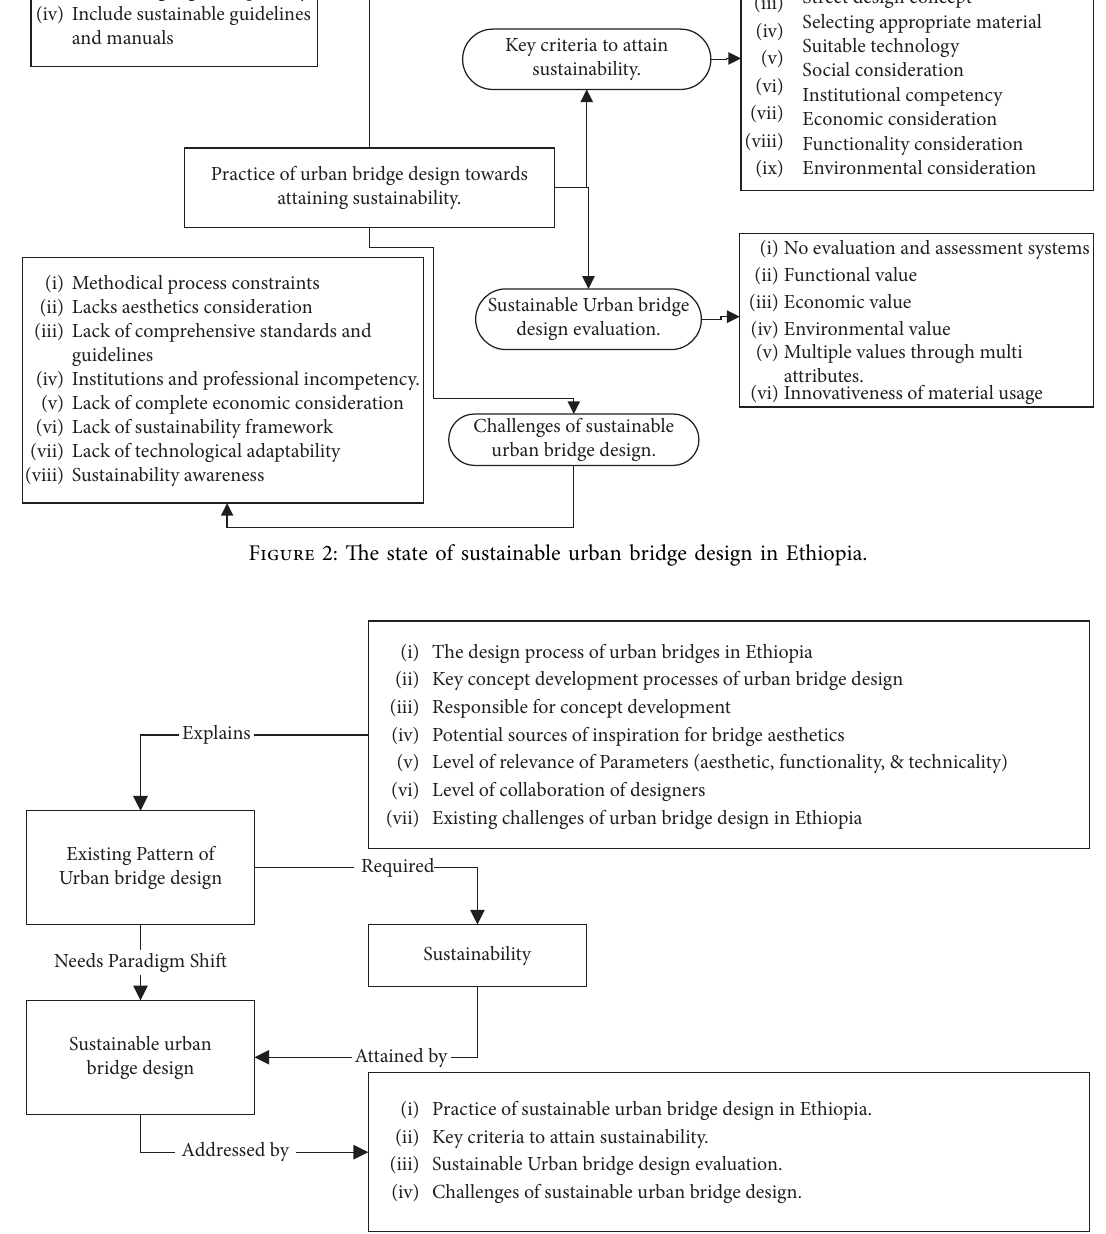
Figure 3: A mechanism of sustainable urban bridge